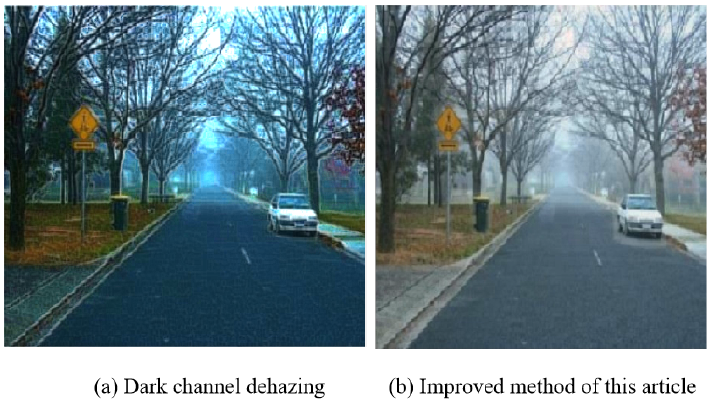
Figure 3. Comparison of the defogging effect of two